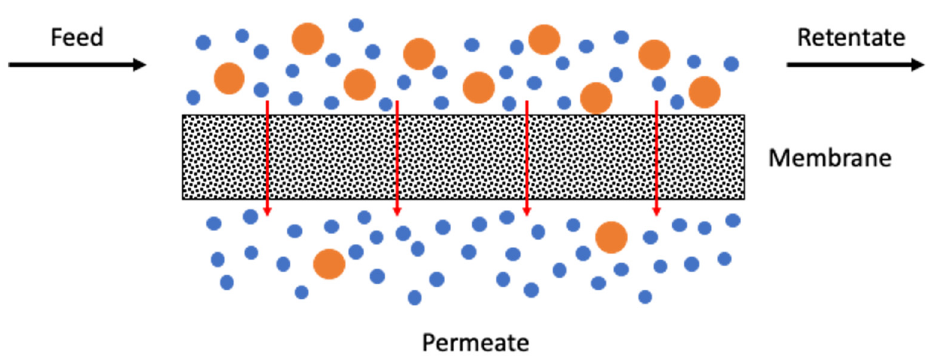
Figure 1. Scheme of a membrane separation.